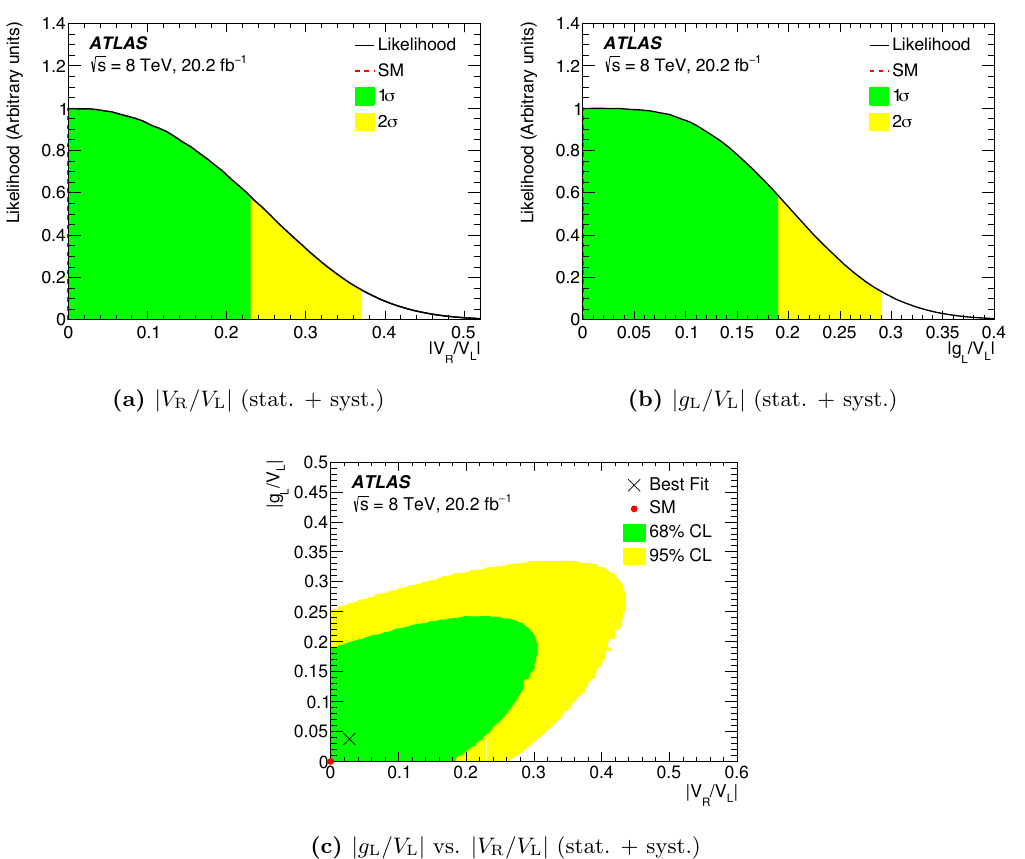
Figure 12. The likelihood pro(cid:12)les for the parameters (a) V R =V L and (b) g L =V L are shown. The j j j j black line indicates the evaluated likelihood in each bin of the pro(cid:12)led variable. The red dashed line, which overlaps the y -axis, represents the SM expectation. Additionally (c), the joint likelihood contour of g L =V L as a function of V R =V L is shown. The red point, which overlaps with the origin j j j j of the x - and y -axis, represents the SM expectation while a black x mark indicates the observed value. The 68% and 95% CL regions are shown in green and yellow,